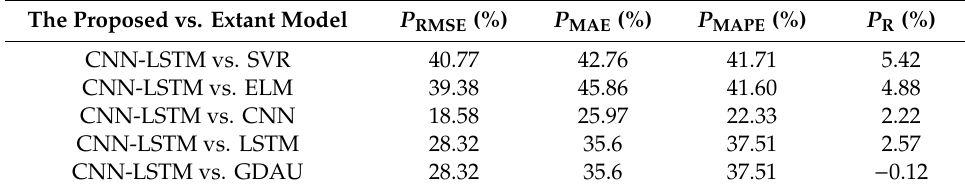
Table 6. Improved percentages between compared models and the proposed model. The Proposed vs. Extant